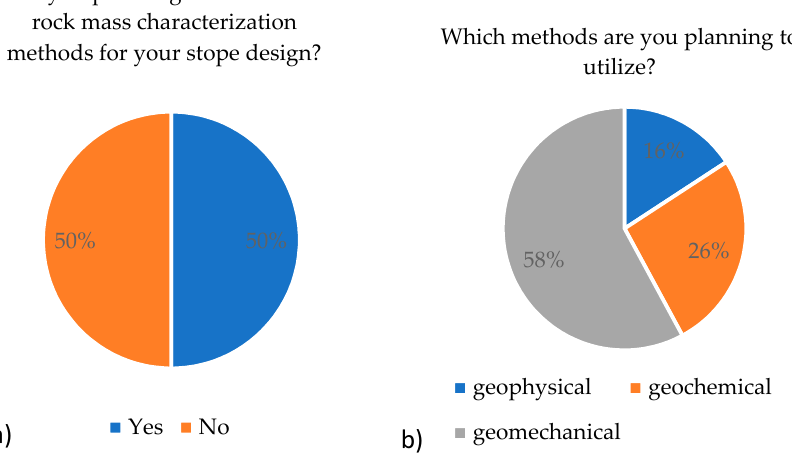
Figure 12. The current utilization of rock mass and ore investigation methods in the mines ( a ) and the type of method that is used to collect rock mass and ore data ( b ).